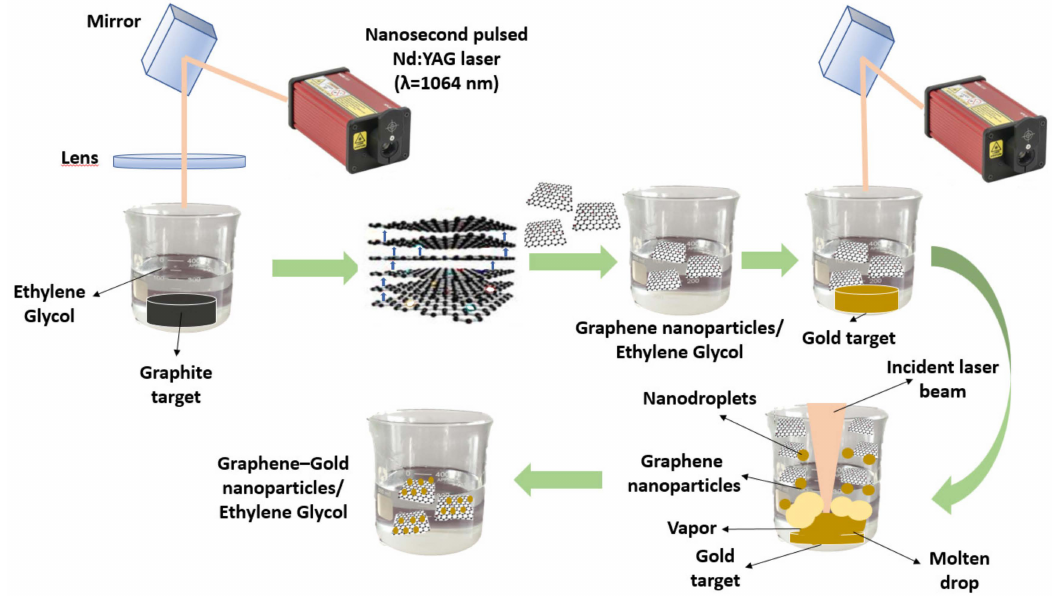
Figure 12. Preparation method of the Gr-gold nanoparticles in ethylene glycol 2D nanofluid. Adapted from